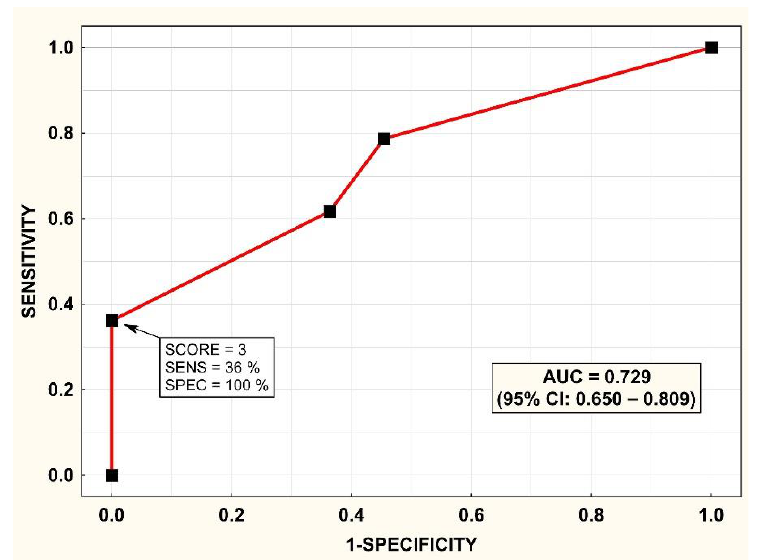
Figure 5. Prediction of unilateral primary aldosteronism (PA) in the validation cohort: receiver operating characteristic (ROC) curve for the SCORE. Abbreviations as in Figure 2.